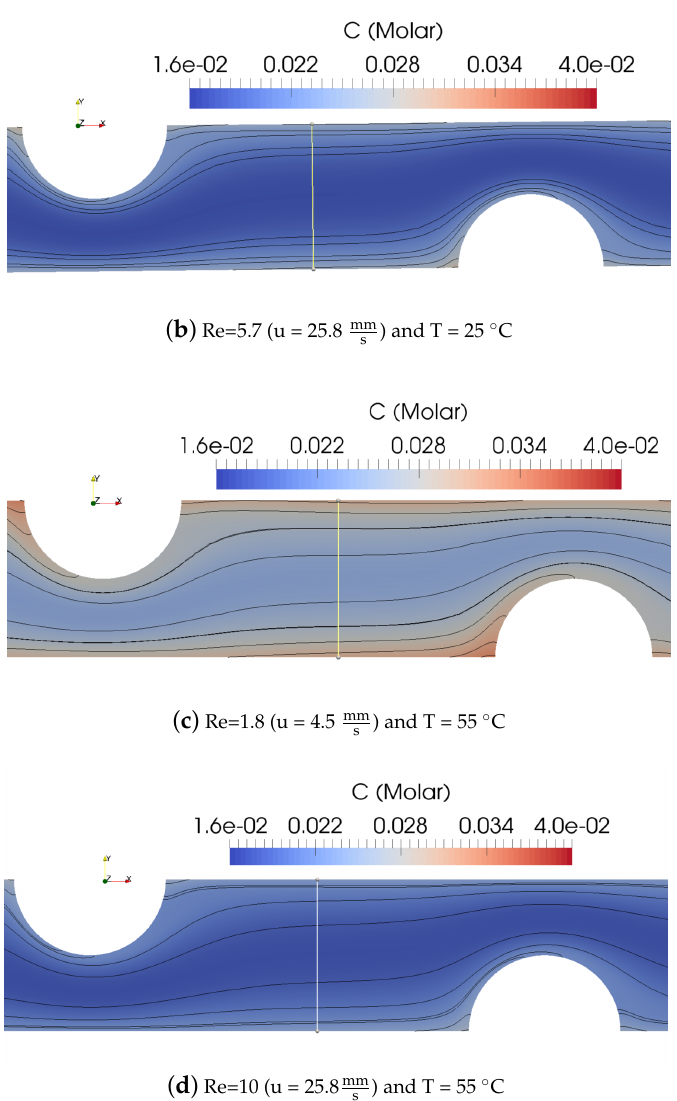
Figure 5. Concentration contour maps for dilute solution in a cylindrical corrugated channel at different Re numbers and